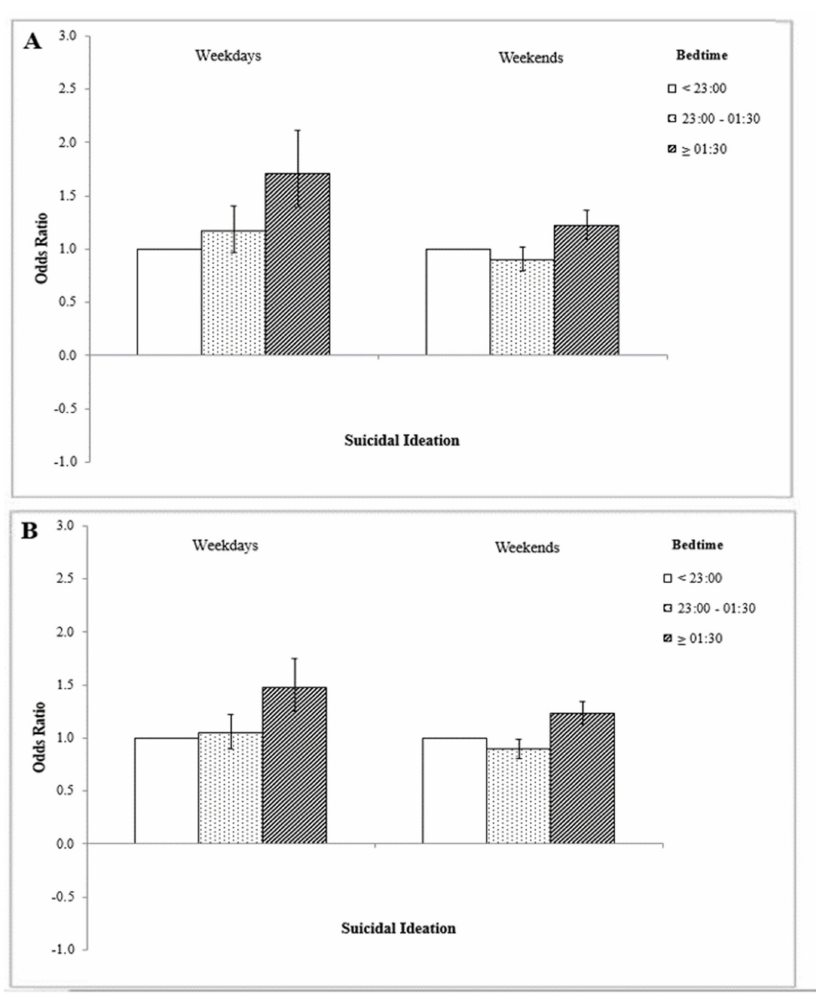
Figure 1. ( A ) Difference in suicidal ideation among men in terms of bedtimes on weekdays and weekends. ( B ) Difference in suicidal ideation among women in terms of bedtimes on weekdays and